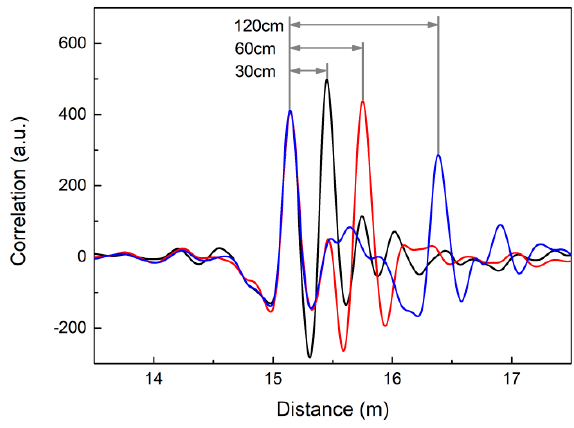
Figure 10. Detection results of two intruders with different spacing distances.